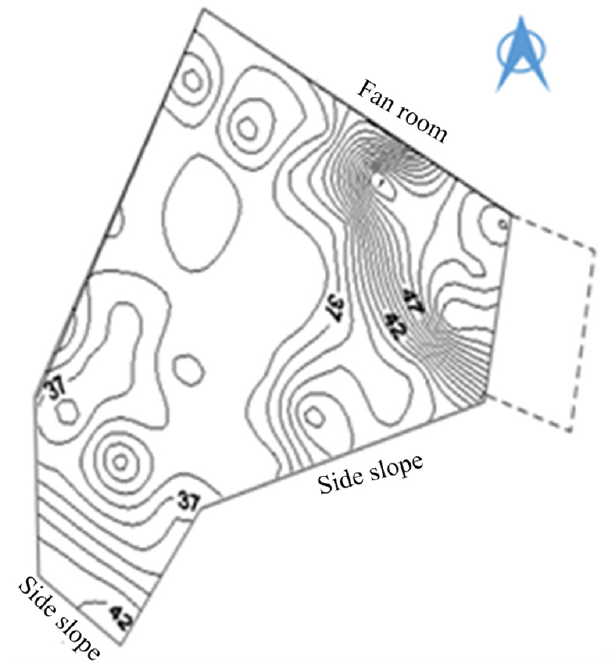
Figure 11. Surface temperature equivalence of coal gangue hill.